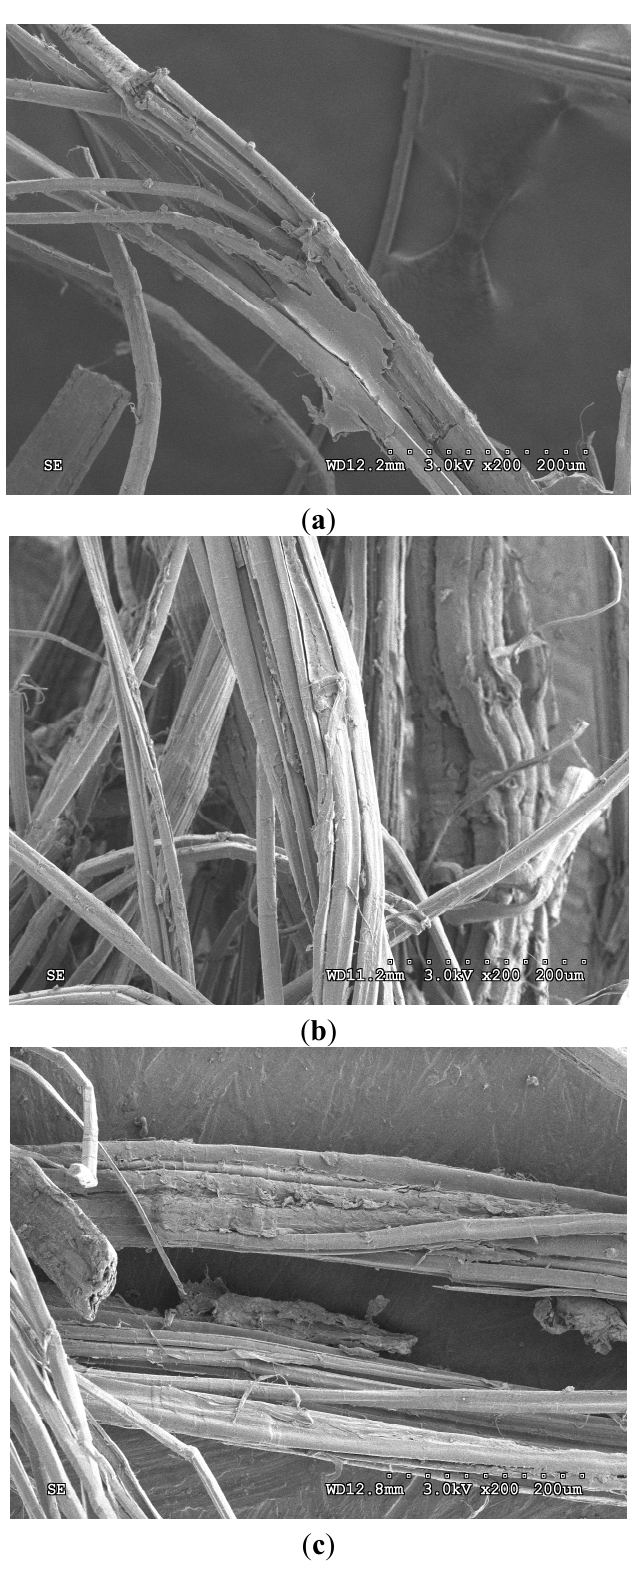
Figure 6. Electron microscope images of CNFC showing ( a ) untreated; ( b ) saturated and ( c ) redried samples that have been fractured under tensile